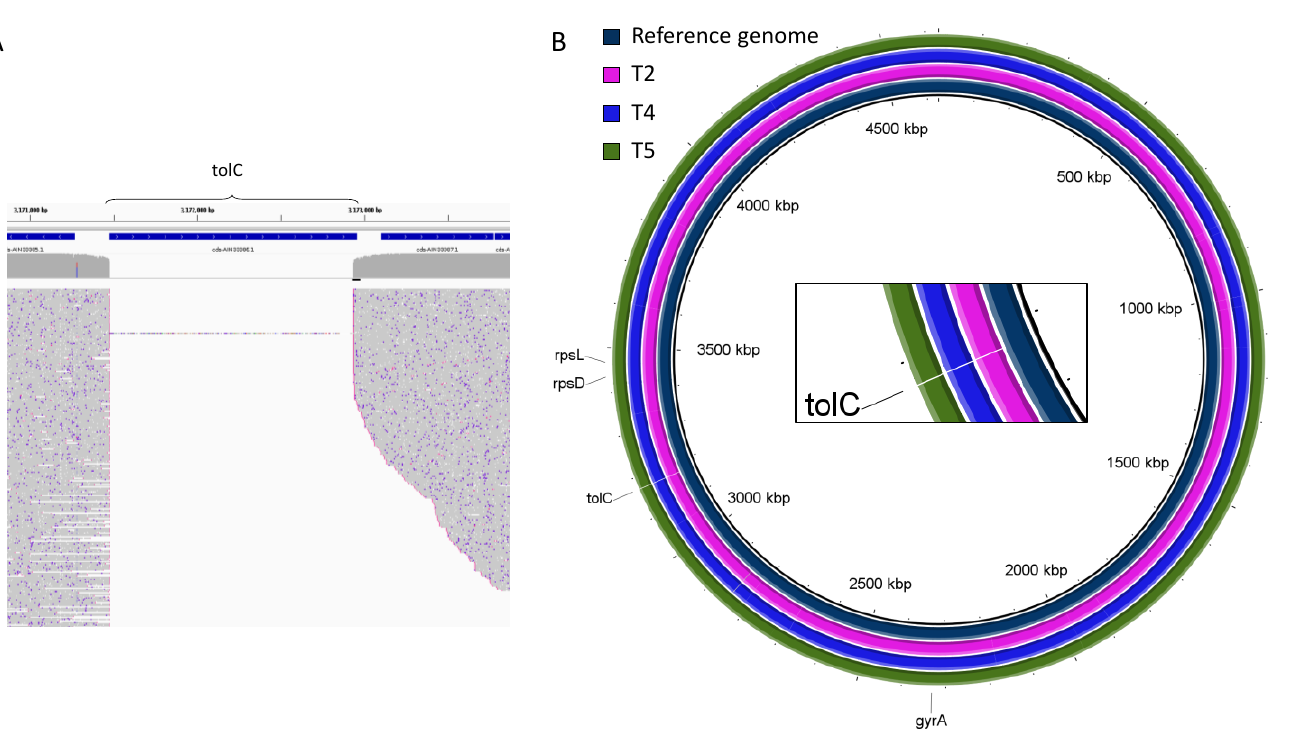
Figure 2. Deletion of the tolC gene. Alignment of ( A ) ONT reads to the reference genome of the E. coli ( B ) de novo assembled genomes on the reference genome of the E. coli . All genes that are considered in this study are marked.